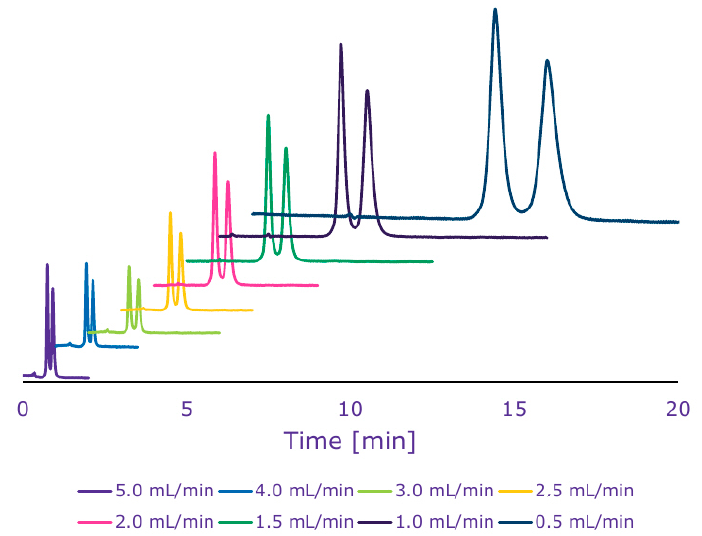
Figure 1. Representative chromatograms showing the separation of terbutaline enantiomers at different flow rates using cellulase immobilized epoxy monolithic silica columns. Reprinted with permission from Merck KGaA, Darmstadt, Germany.